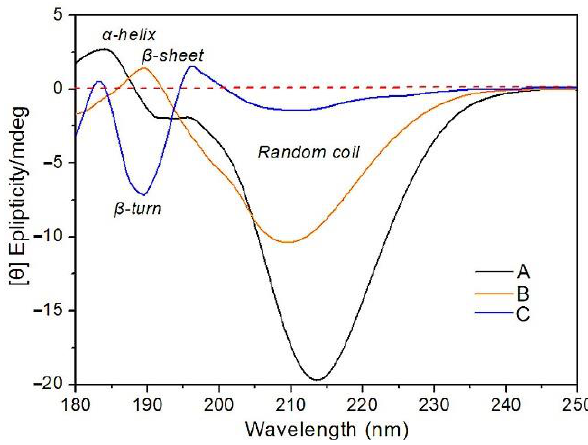
Figure 6. Circular dichroism spectroscopy (CD) spectra of CS (A), CSC (B), CSS (C).